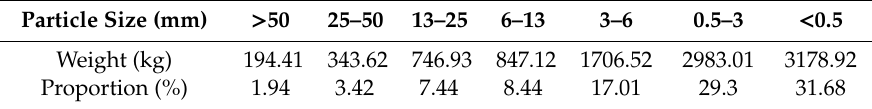
Table 1. The natural coal particle size distribution of the No. II-1 coal seam in the Gaocheng coal mine after screening.